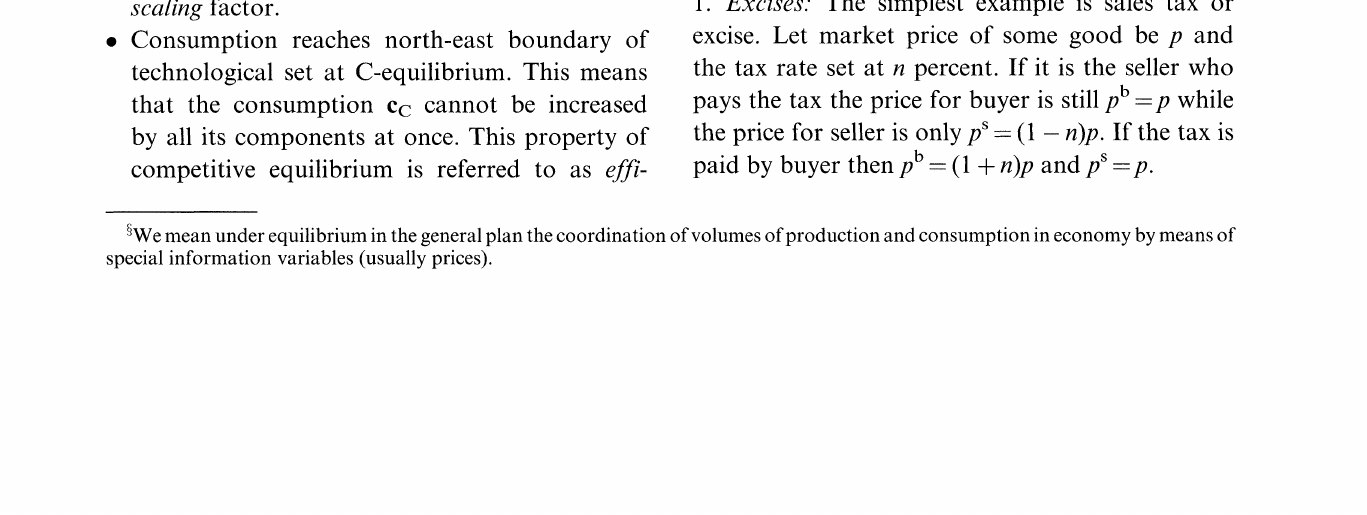
Fig. 2. Suppose that measure of expenditures is chosen so that the boundary of is mapped on the boundary of T. Since C-equilibrium maximizes utility it will be represented by the top point of i?. The arguments above show that C-equilibrium exists and corresponding mate- x:, y: rial flows ec, are determined uniquely. Equilibrium prices Pc and income Ic are deter- mined uniquely up to an arbitrary positive price scaling factor.